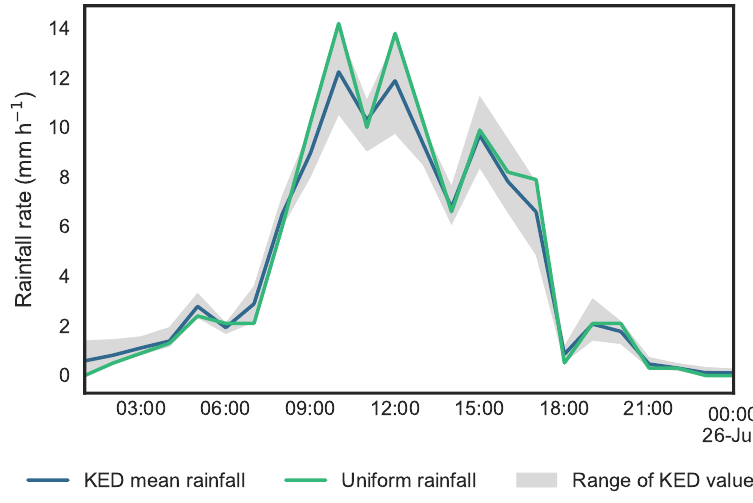
Figure 8. Hyetographs of the two considered rainfalls above the study area on 25 June